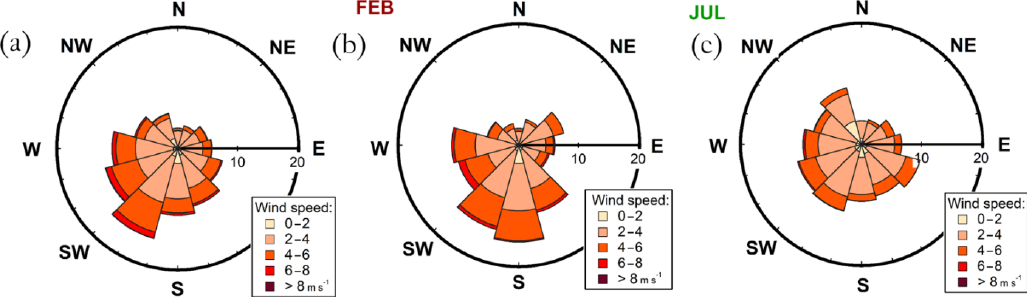
Figure A1. Wind rose diagrams during the overall measurement period (a) , February (b) , and July (c) . The distance from origin reflects the likelihood of each direction (%) and the color scale reflects the likelihoods of different wind speeds associated with the direction.